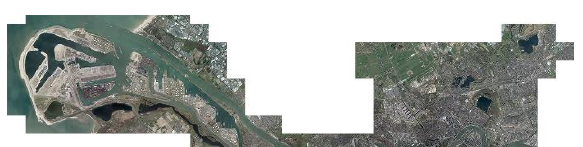
Figure 6. Workflow for requesting tiles from the cloud For the cache Amazon S3 storage is used. If the tile is in the cache it is sent back to the client. In the case the tile isn’t available Figure 7. The orthophoto of Rotterdam